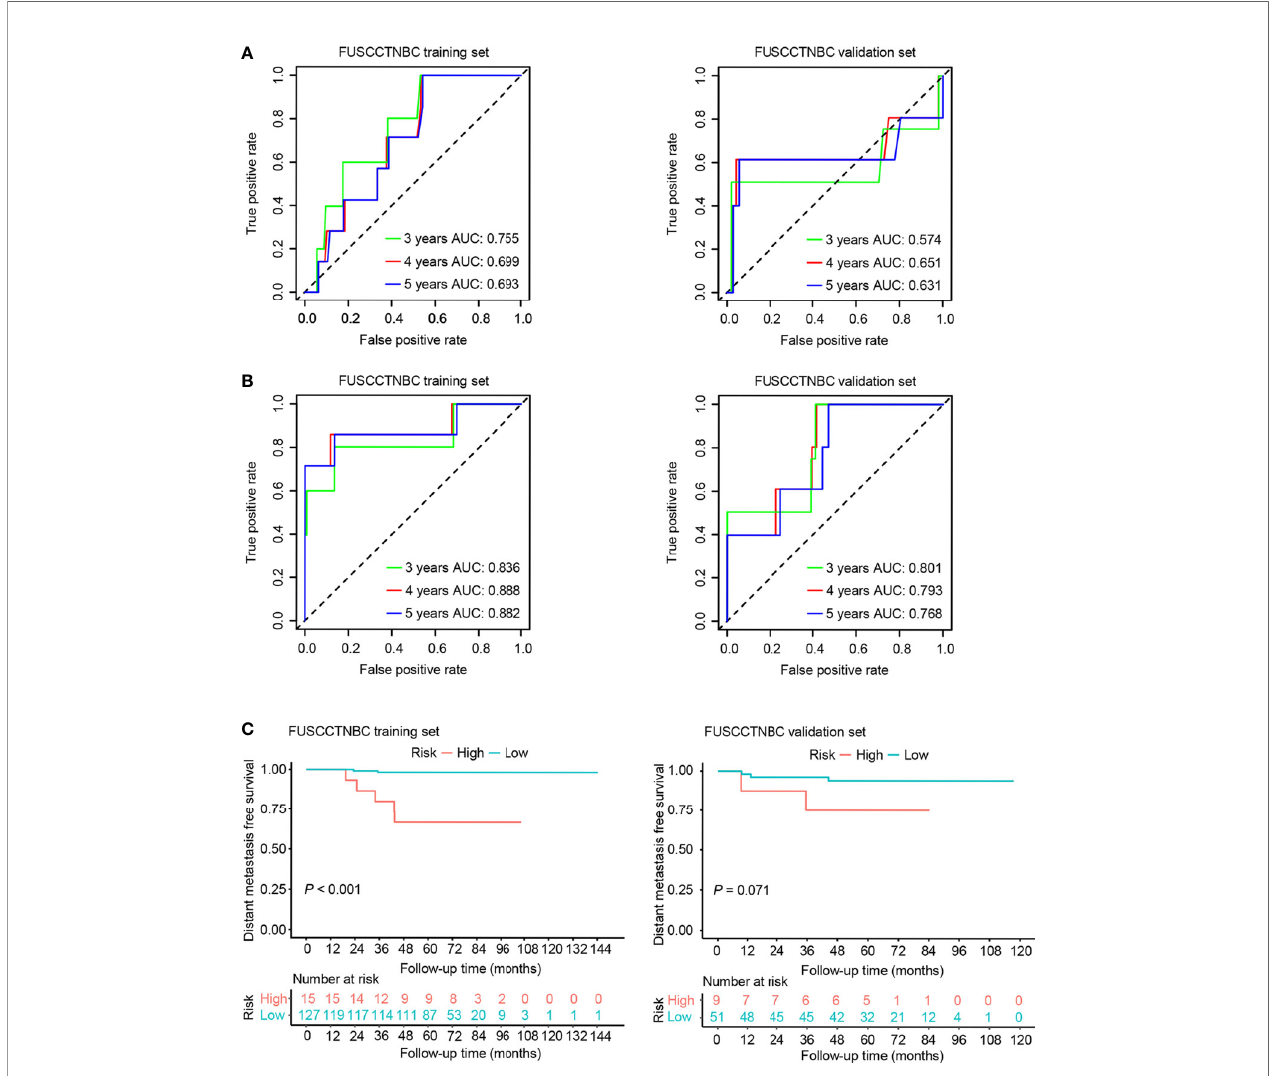
FIGURE 4 | Time-dependent receiver operating characteristic (ROC) and Kaplan – Meier survival analysis for the clinical model and combined model in the training set and validation set of the lymph node-negative triple-negative breast cancer (TNBC) cohort. AUC, area under the curve. (A) Time-dependent ROC curves of the clinical model for 3-, 4-, and 5-year distant metastasis-free survival (DMFS). (B) Time-dependent ROC curves of the combined model for 3-, 4-, and 5-year DMFS. (C) Kaplan – Meier plots of the combined model illustrating that the patients in the high-risk group showed poorer DMFS than those in the low-risk